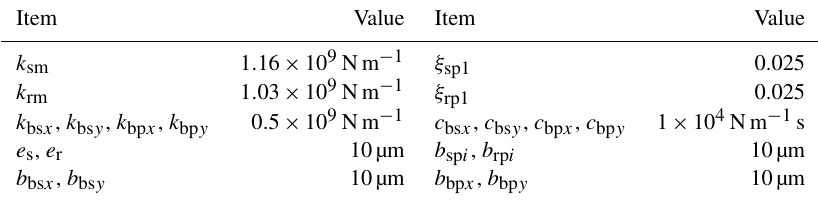
Table 2. Dynamic parameters of planetary system. Item Value